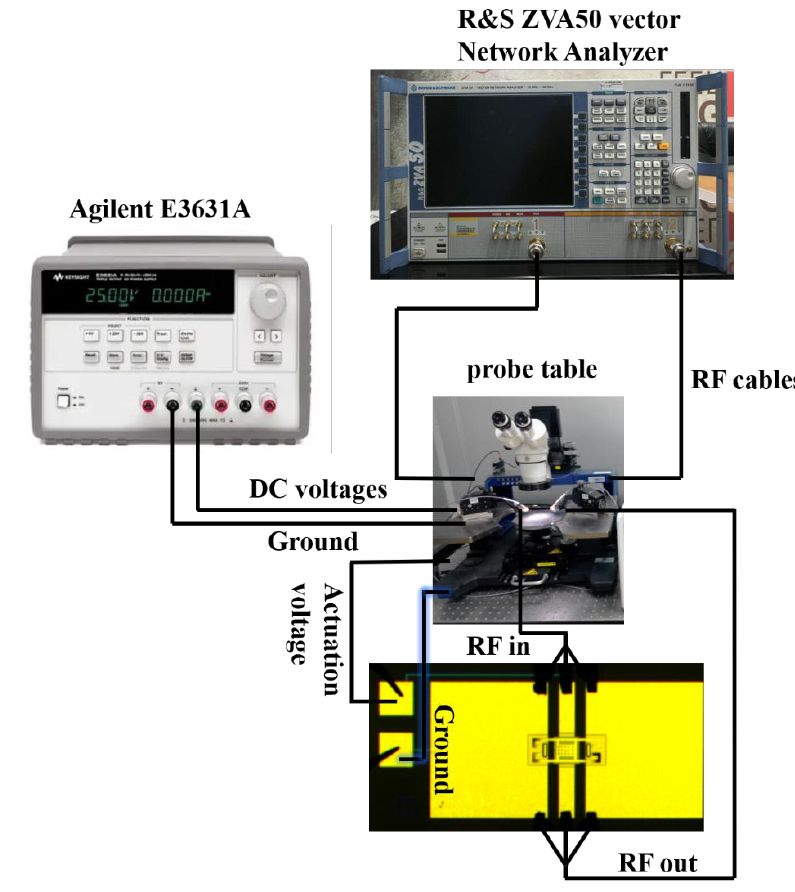
Figure 14. The RF measurement setup of the switch. The measured S parameters are shown in Figure 15.